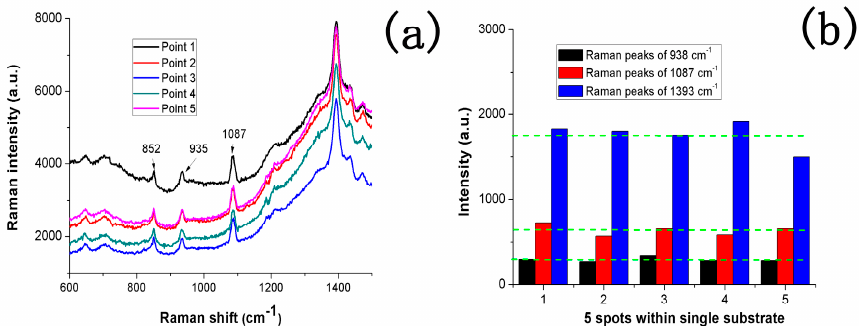
Figure 5. ( a ) SERS spectra of PA (10 − 5 mol/L) adsorbed on AgNP-decorated PS PC substrate, obtained from five random spots; ( b ) The transverse dash line shows the average SERS intensity of the five random spots within single substrate.